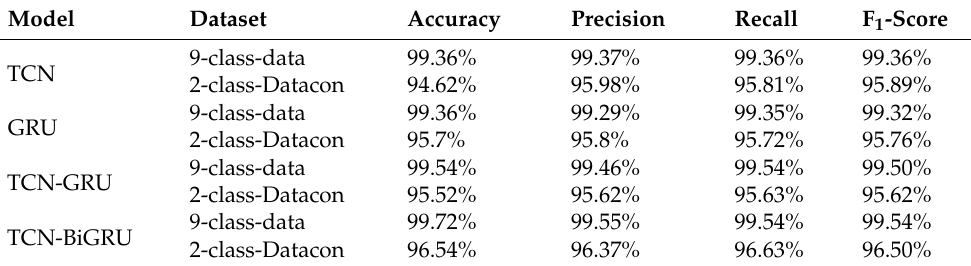
Table 6. Ablation experiment of model.